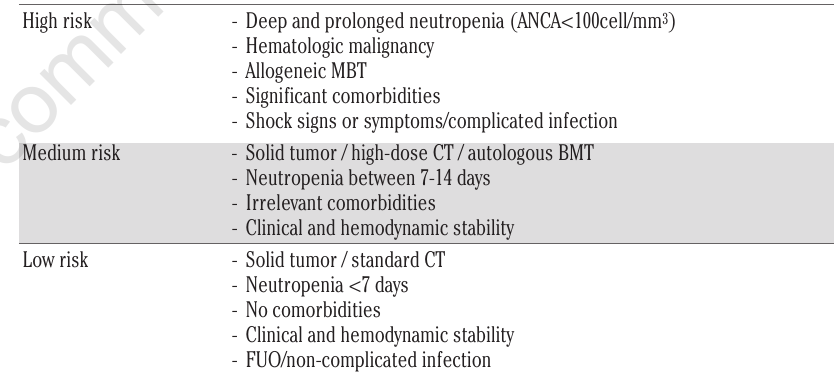
Table 3. Risk Assessment: ASH 2001 Guidelines. 11